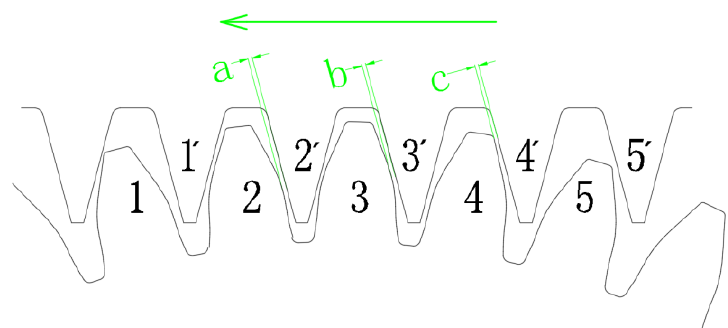
Figure 9. Traditional meshing between steel worm & helical gear (a = b =